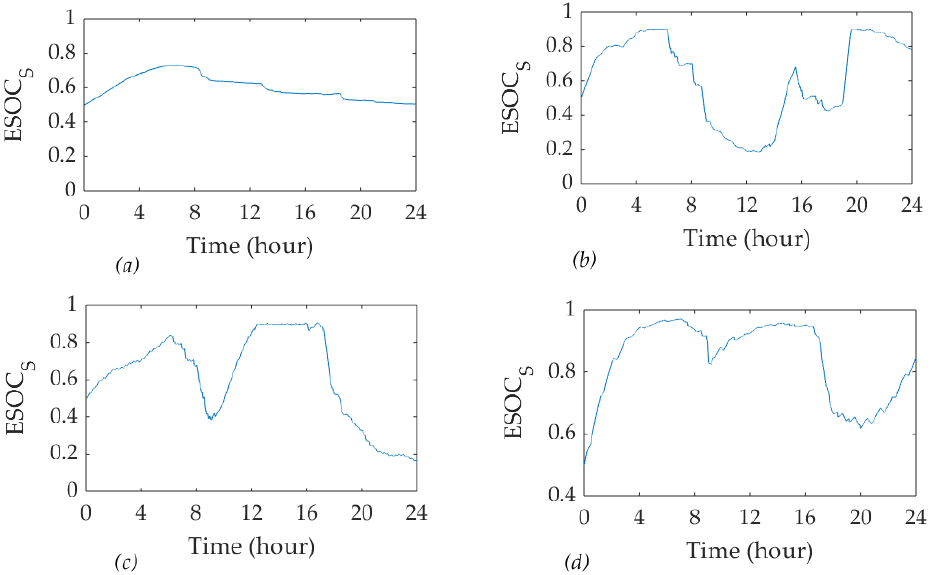
Figure 11. ESOC S profiles of the storage system in the four days. ( a ) spring day; ( b ) summer day; ( c ) autumn day ( d ) winter day.